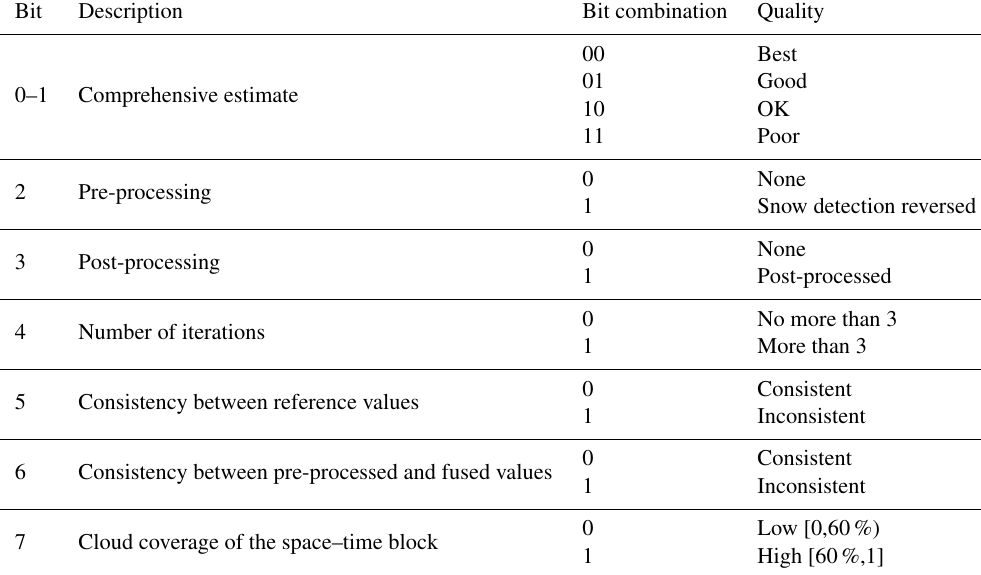
Table 3. Bit flags indicating the retrieval conditions according to the raw NDSI dataset.